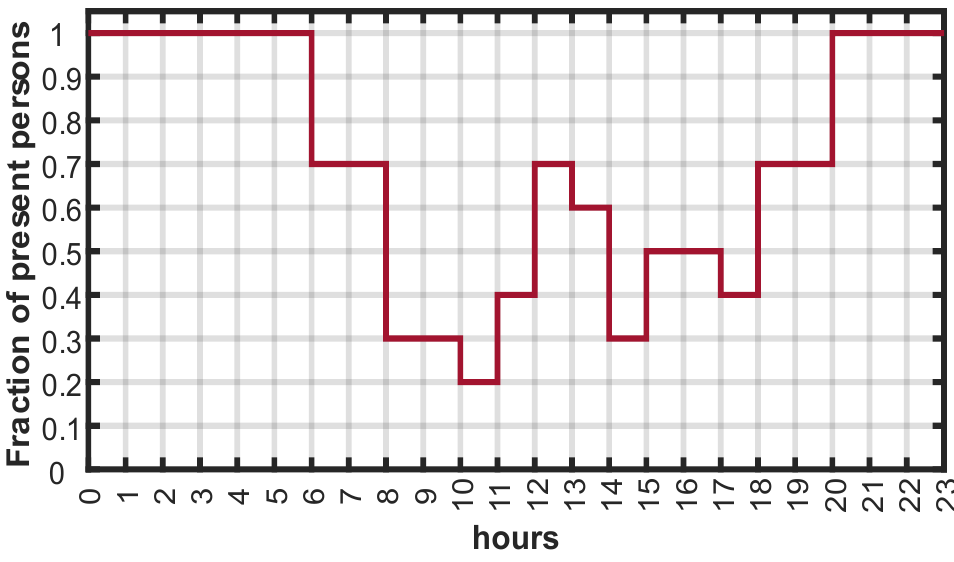
Figure 7. Daily occupancy of a typical rural Kyrgyz house.